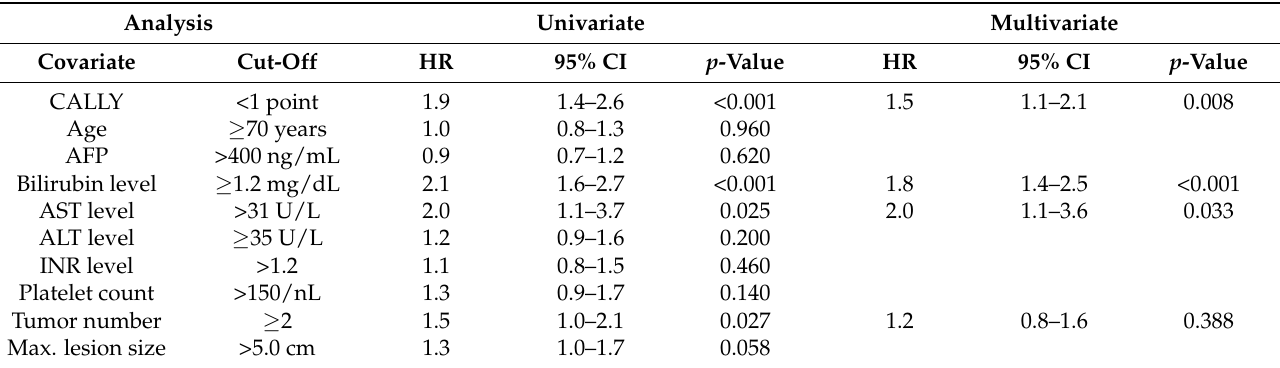
Table 2. Univariate and multivariate analysis results for all patients.